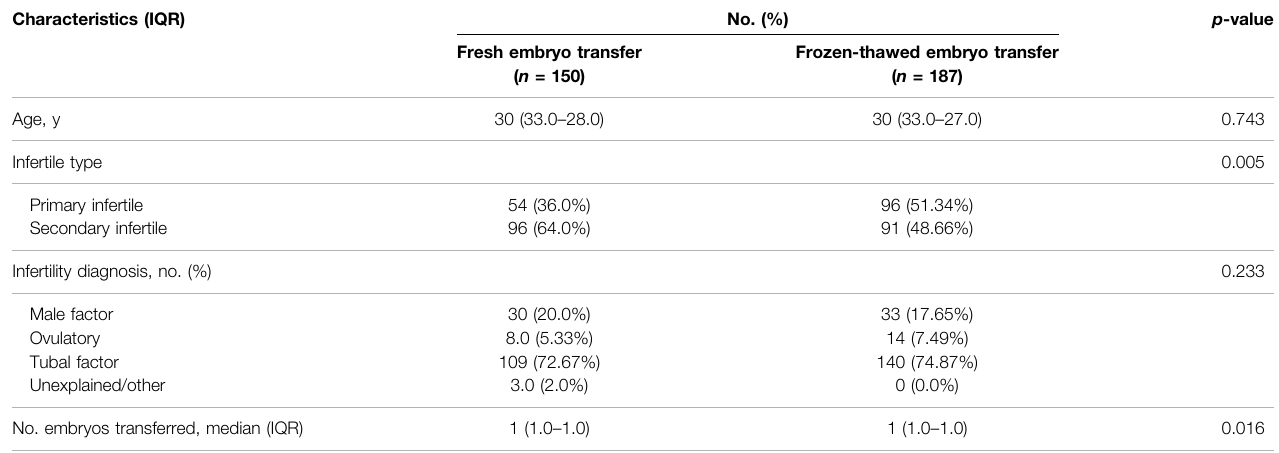
TABLE 3 | Baseline patient characteristics of women with fresh blastocyst transfers and frozen – thawed blastocyst transfers. Characteristics (IQR)